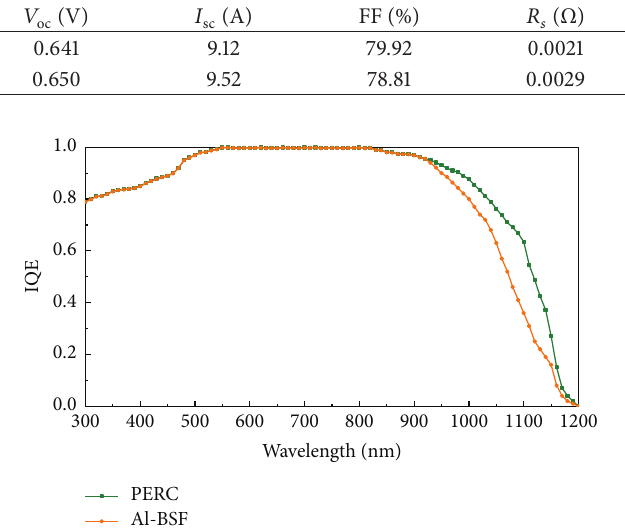
Figure 3: The internal quantum efficiency of Cz-Si silicon solar cells with Al-BSF and PERC